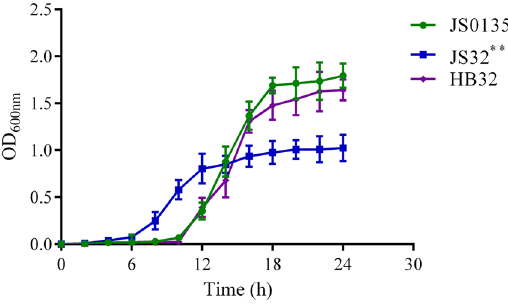
Figure 1. Growth curves of JS0135 , JS32 and HB32 . * Presents statistically significant p ≤ 0.05, ** presents extremely significant p ≤ 0.01.